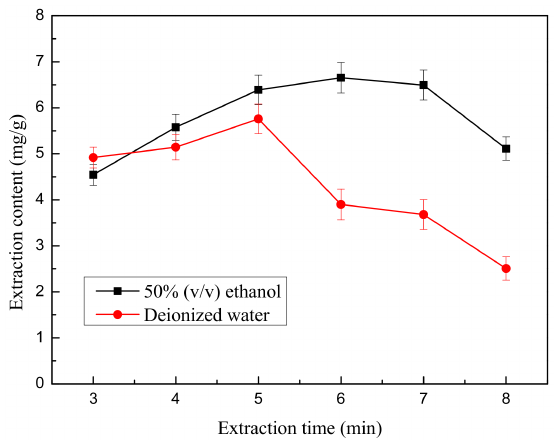
Figure 5. Effect of different microwave treatment times by different solvents on microwave